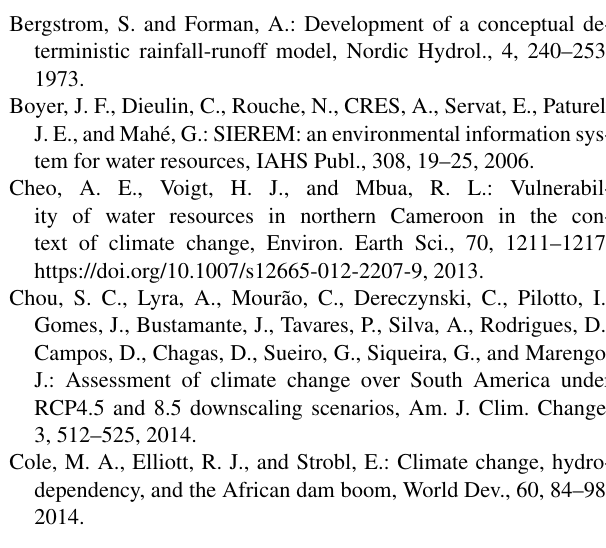
Data availability. Meteorological and hydrological data are the properties of the Direction of the National Meteorology of Cameroon (DNM) and the SIEREM/HSM database